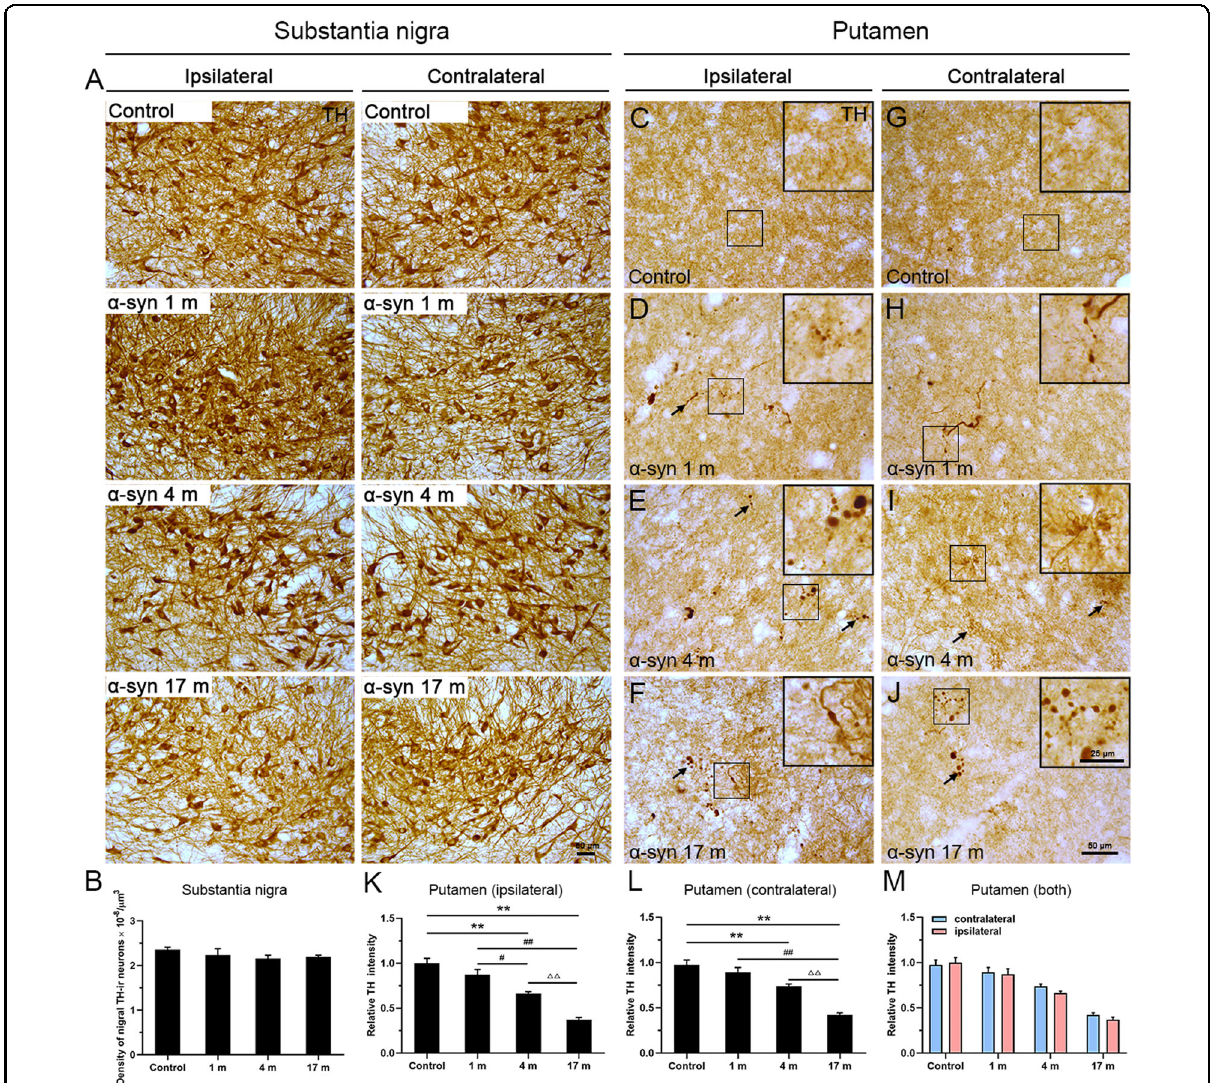
Fig. 8 Immunohistochemical images showing TH-positive dopaminergic neurons and terminals in the substantia nigra and putamen. A Dopaminergic neurons appeared to have a normal morphology without clear degenerative alterations in different groups. B Stereological analyses of dopaminergic neurons in the substantia nigra. C – J Scattered dystrophic axonal swellings were observed in the putamen on both sides, at different time points in response to α -syn PFFs treatment. C , G In comparison, the control displays homogenous distribution with no pathological terminals. K – M Quantitative analyses of the intensity of TH immunoreactivity in the putamen (ipsilateral side: K ; contralateral side: L ; both sides: M ). α -Syn, α -synuclein; TH, tyrosine hydroxylase. The data are presented as the mean ± SEM of three independent experiments. ** p < 0.01 vs. control group, # p < 0.05, ## p < 0.01 vs. 1-month group, ΔΔ p < 0.01 vs. 4-month group, one-way ANOVA ( K , L ). Scale bars: 50 μ m in A , C – J and 25 µm in the